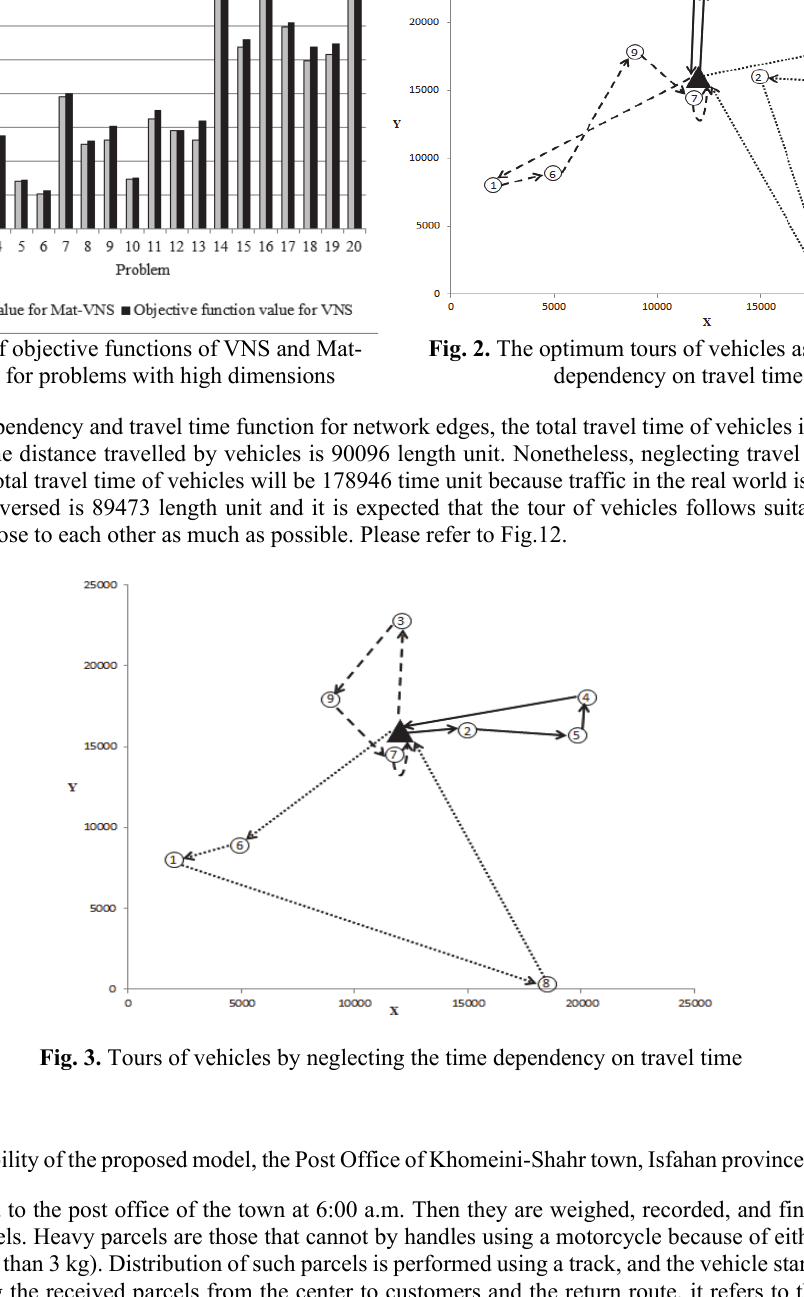
Fig. 2. The optimum tours of vehicles assuming time dependency on travel time